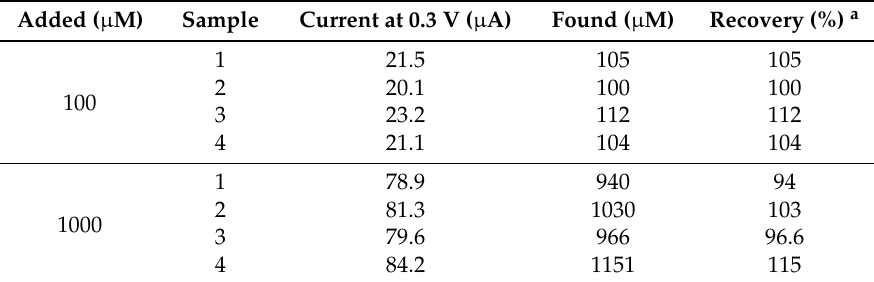
Table 2. Determination of HZ in tap water containing ions.